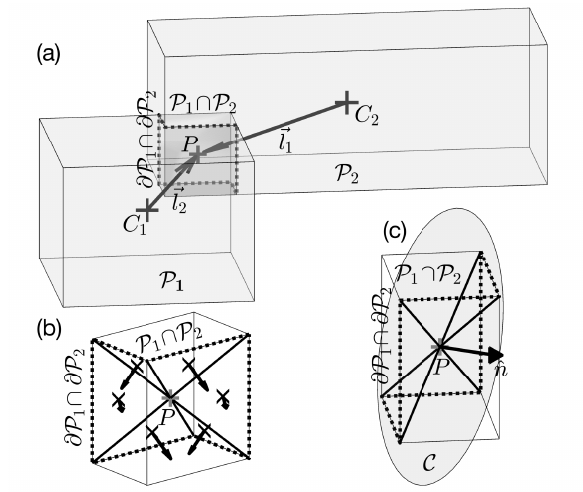
, contacting with the Figure 1. Geometry of two particles P 1 P 2 @ overlap with the dotted seam @ in (a), en- P 1 \ P 2 P 1 \ P 2 larged overlap region, including the triangular contact segments and their normal vectors ~ n i (length proportional to the triangle area) in (b) under a di ↵ erent angle, the averaged contact Plane C and the normal vector ˆ n in